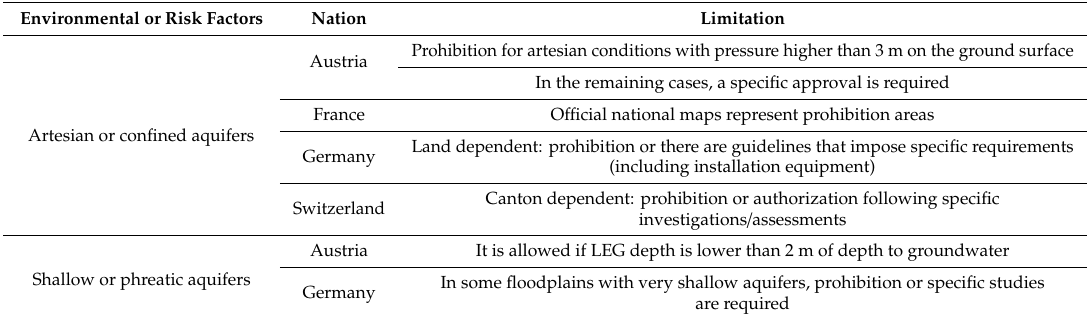
Table 1. Comparison of main hazardous conditions factors taken into account in selected national LEG regulation in